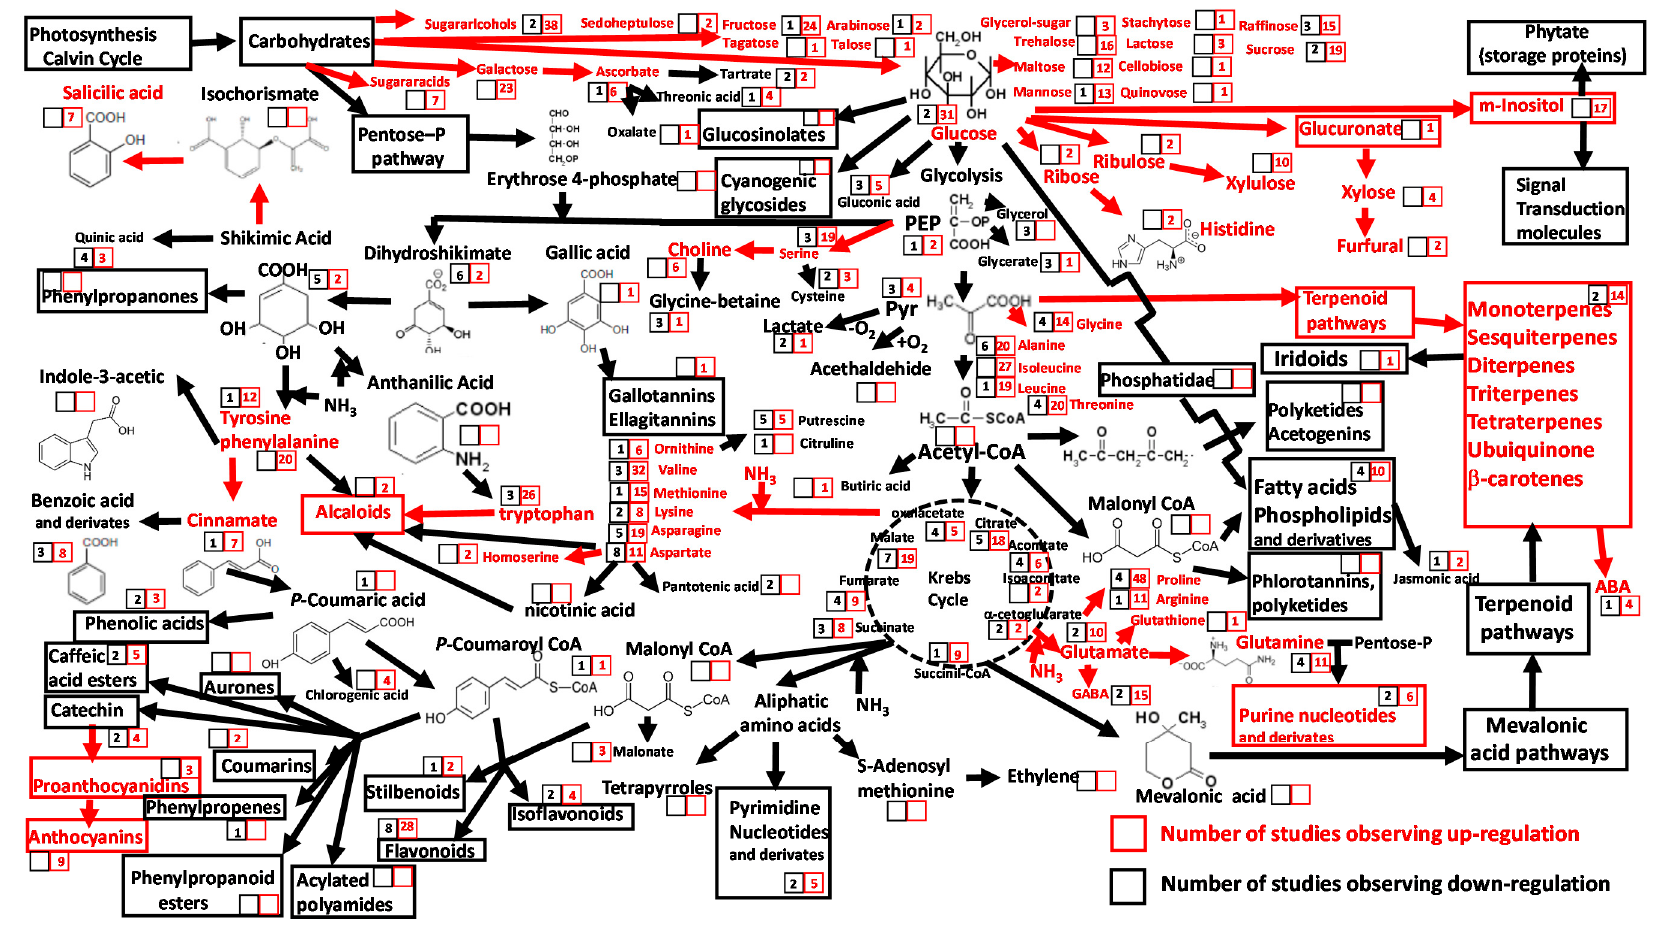
Figure 1. Shifts in principal plant metabolites and metabolic pathways in response to drought conditions reported in 81 ecometabolomic studies. The numbers within the squares are the numbers of reports describing changes in photosynthetic tissue metabolite concentration and / or pathway activity under drought stress. Red numbers within red squares indicate significant increases; black numbers within black squares indicate significant decreases. Red arrows indicate upregulation of the metabolic pathway; bold black arrows indicate no changes.